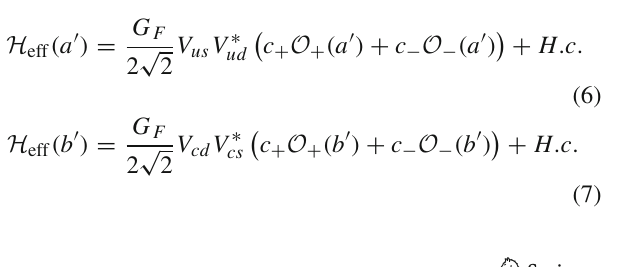
baryon decays, the (cid:2) C = 0 single charm baryon decays, the triplet double charm baryon decays to the antitriplet and sextet single charm baryons, and the double charm baryon decays to the light baryon octet and heavy D , D